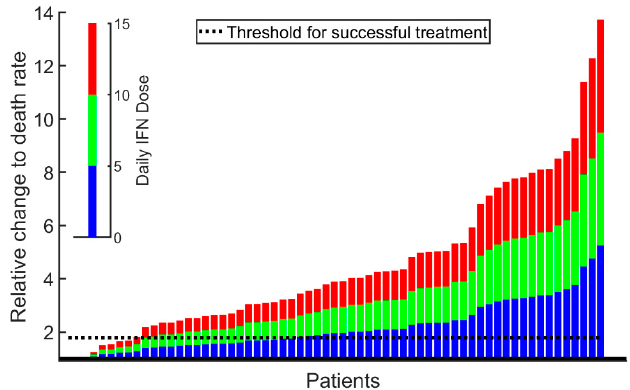
Figure 7. From the Cancitis model, it can be computed whether the specific patient dose–responses suffice to force the patient towards a healthy or a diseased state (i.e., the cancer is about to be eradicated or the cancer escapes with ensuing disease progression). Each patient prediction in the study is represented by one column. The blue part of the columns depicts if the patient received an average daily dose of 5 µg IFN, the green depicts if the patient received 10 µg IFN per day on average, and the red depicts if the patient received 15 µg IFN per day on average. If the top of the columns are above the black dashed line, corresponding to 1.8-fold increase in the malignant stem cell death rate, the patient is said to respond well to the treatment—i.e., the allele burden steadily declines and so do the leukocyte and thrombocyte counts. For an average daily dose of 15 µg, the model predicts that there are 3 non-responders (not visible) at the left most part of the figure, followed by 6 poor responders. The remaining 54 are good responders. A similar interpretation can be made for an average daily dose of, e.g., 5 or 10 mg IFN. A stratification of the figure into patients receiving Pegasys and PegIntron, respectively, resembles the merged figure but with lower number of patients.